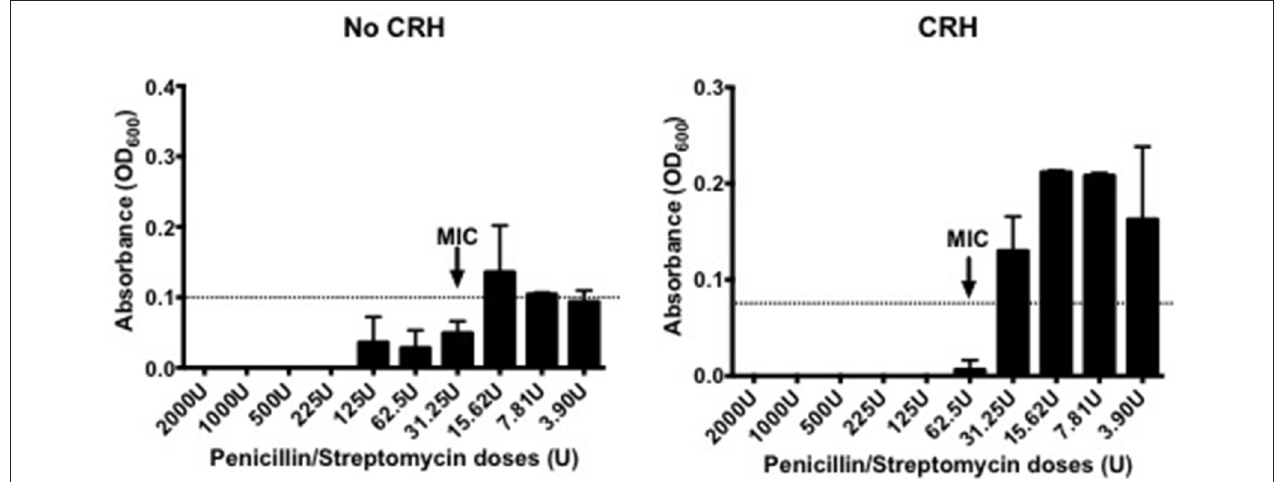
FIGURE 3 | CRH increases antibiotic resistance. Serotype 1 pneumococcal strain were incubated for 2h in the presence or absence of CRH (4.0 × 10 − 4 mM/ µ l), and subsequently exposed overnight to various penicillin/streptomycin concentrations (2,000, 1,000, 500, 225, 125, 62.5, 31.25, 15.62, 7.81, and 3.9 U/well). Data represents one of three independent experiments performed in triplicate. Arrow indicates the minimal inhibitory concentration (MIC).